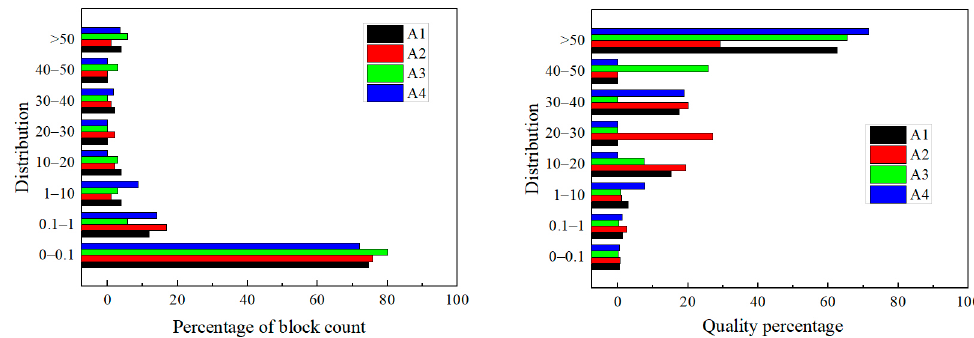
Figure 6. Distribution of number of blocks and percentage of block mass.